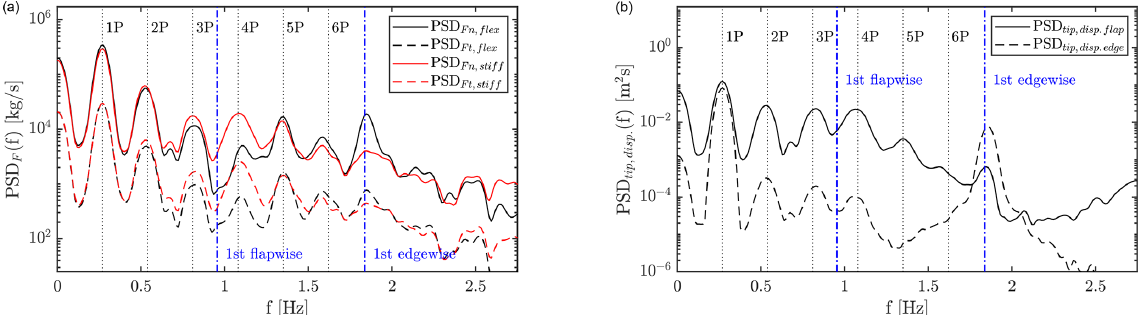
Figure 17. (a) PSD of normal and tangential forces at 78% blade length for both stiff and flexible simulations. (b) PSD of tip displacement in flap- and edgewise